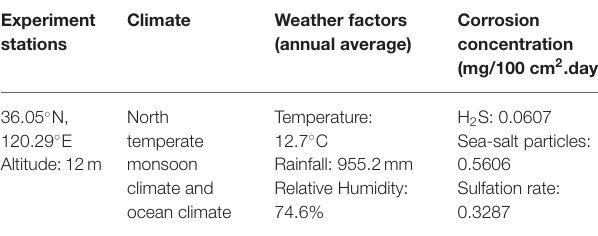
TABLE 1 | Environmental data during the